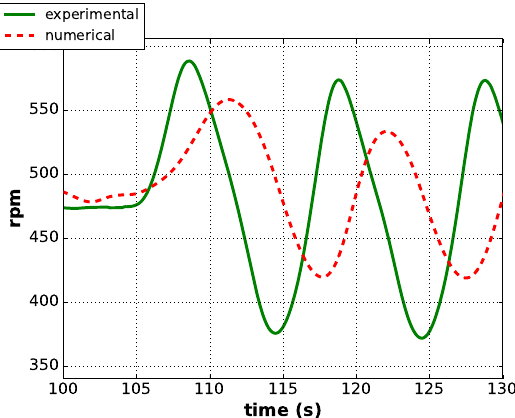
Figure 7. Time series of the rotor speed for test